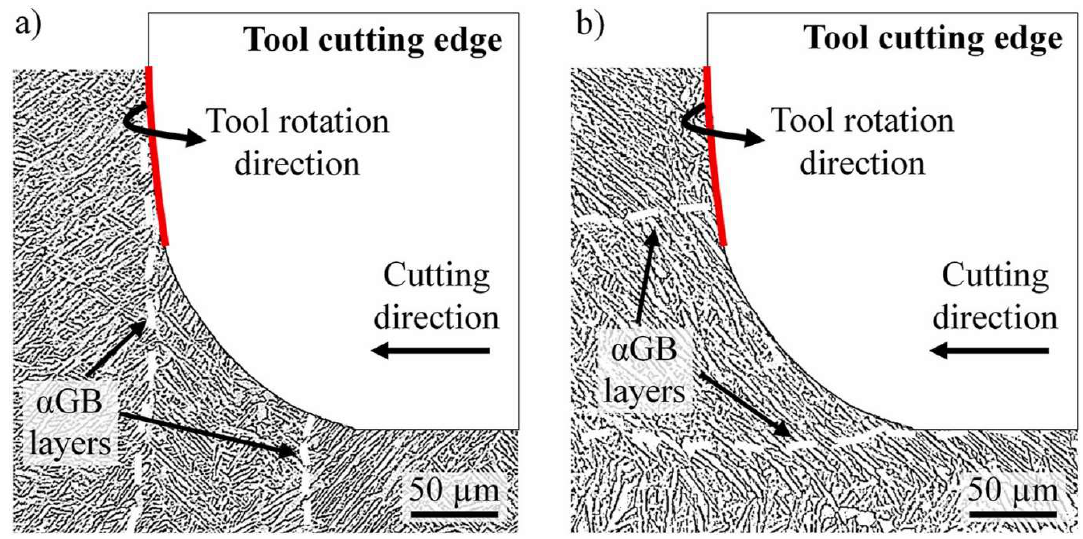
Figure 19. Microstructural interaction when milling 0 deg ( a ) and 90 deg ( b ) oriented PBF-LB Ti-6Al-4V samples [158] (Reprinted with permission from [158]. Copyright 2021, Elsevier).